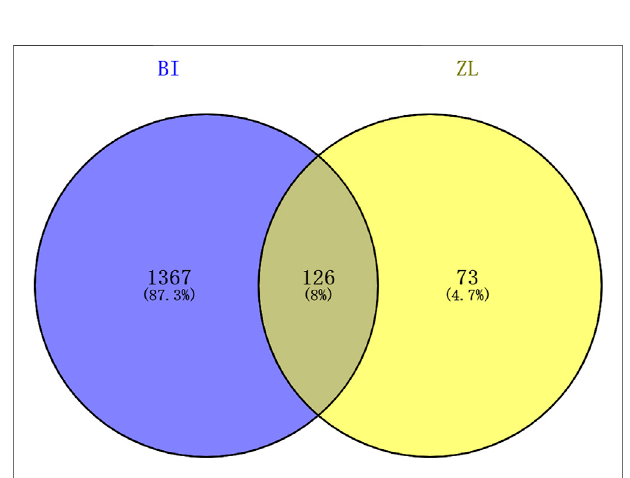
FIGURE 1 | Venny intersection diagram between cerebral ischemia – reperfusion and ZLH.